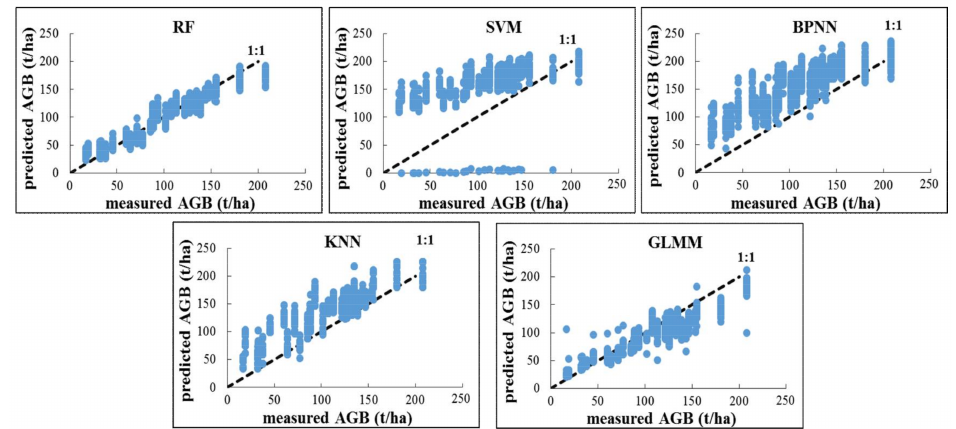
Figure 4. Predicted AGB vs. measured AGB. The black dotted line represents the 1:1 line. RF, Random Forest; SVM, Support Vector Machines; BPNN, Back Propagation Neural Networks; KNN, K-Nearest Neighbor; GLMM, Generalized Linear Mixed Model.